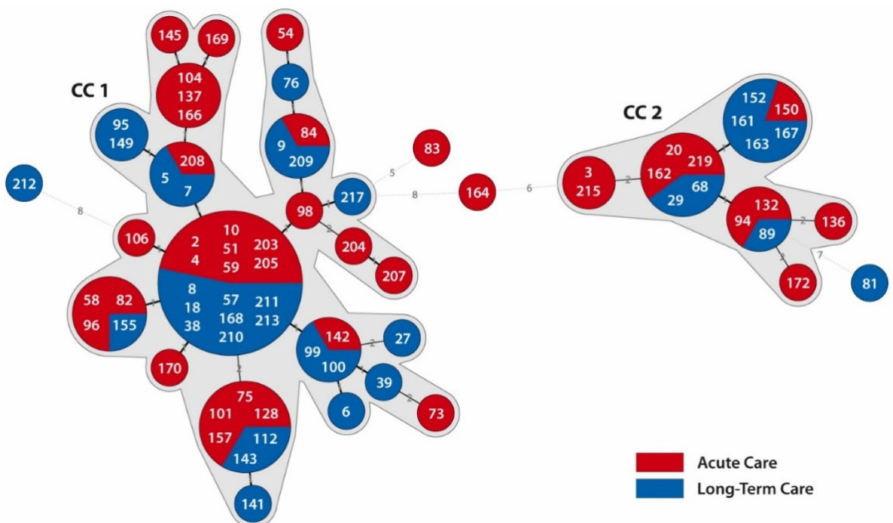
Figure 4. Minimum spanning tree (MST) of Clostridioides ( Clostridium ) di ffi cile isolates of ribotypes 176. A MST was created by Bionumerics v5.0 (Applied Math) using the Manhattan coe ffi cient. The numbers in circles represent the DNA number of C. di ffi cile isolates. The numbers on the lines represent the sum of tandem repeat di ff erences (STRD) between isolates. If more than one number is present in one circle, it represents isolates with STRD = 0. A clonal complex (CC) was defined as STRD ≤ 2. The red color indicates C. di ffi cile isolates derived from patients hospitalized in acute care wards and the blue color represents C. di ffi cile isolates derived from patients hospitalized in a long-term care